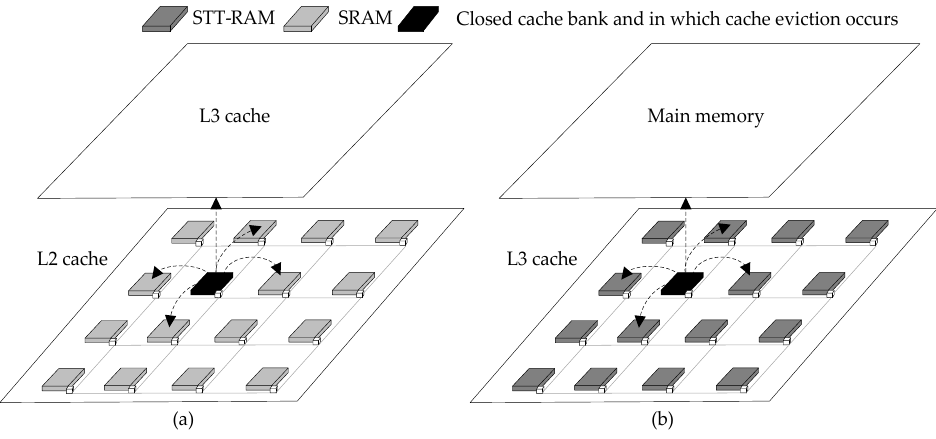
Figure 5. Two classes of migrations. ( a ) Migrations in L2 cache, and ( b ) migrations in L3 cache.